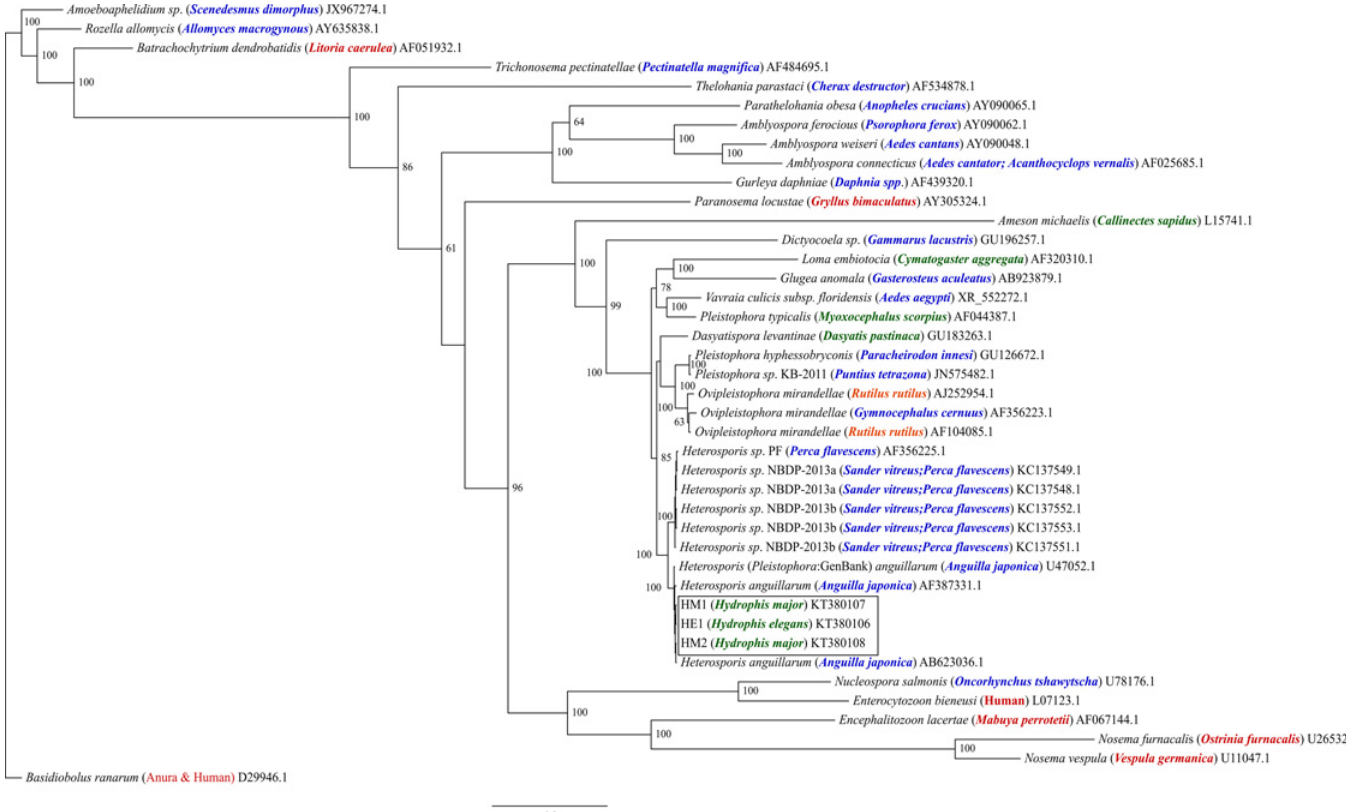
Fig 5. Bayesian analysis of the relationships of sea snake microsporidia (HM1, HM2 and HE1) and representatives of each major microsporidian group based on the ssrRNA gene. PhyloBayes tree topology was constructed from 41 sequences using the GTR + G + I model. Bayesian posterior probabilities are listed as percentages and only values above 50 are shown. GenBank accession numbers are listed after species and host species names. Host species are denoted in parentheses. Color denotes predominant host habitat type (Red; terrestrial, Green; marine, Blue; freshwater, Orange; brackish). Scale bar indicates the number of nucleotide substitutions per